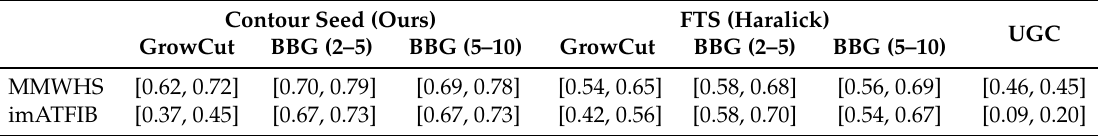
Figure 7. Sample segmentations of imATFIB images. From left to right: image with FTS (Haralick) seed superimposed (yellow: foreground, cyan: background), image with contour-based seed superimposed, GrowCut segmentation using FTS (Haralick) seed, GrowCut segmentation using contour-based seed, band-based GrowCut (2–5) segmentation using FTS (Haralick) seed, band-based GrowCut (2–5) segmentation using contour seed, ground truth. Table 5. Ninety-five percent confidence interval of Dice coefficient values obtained using our method, FTS, and UGC.